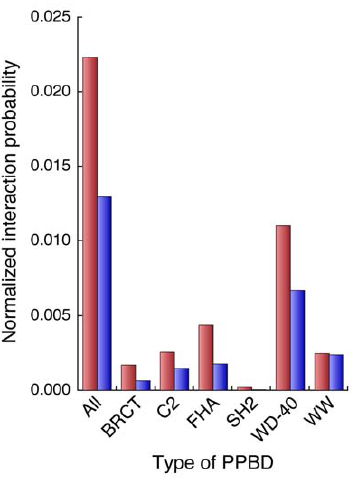
Figure 5. Probabilities that phosphoproteins and nonpho- sphoproteins will interact with proteins that have phospho- protein binding domains (PPBDs). The average normalized interaction probabilities of phosphoproteins (red bars) and nonpho- sphoproteins (blue bars) in the ‘‘ALL’’ phospho-PPI network with each type of PPBD or with all PPBDs (indicated on the horizontal axis) are shown.